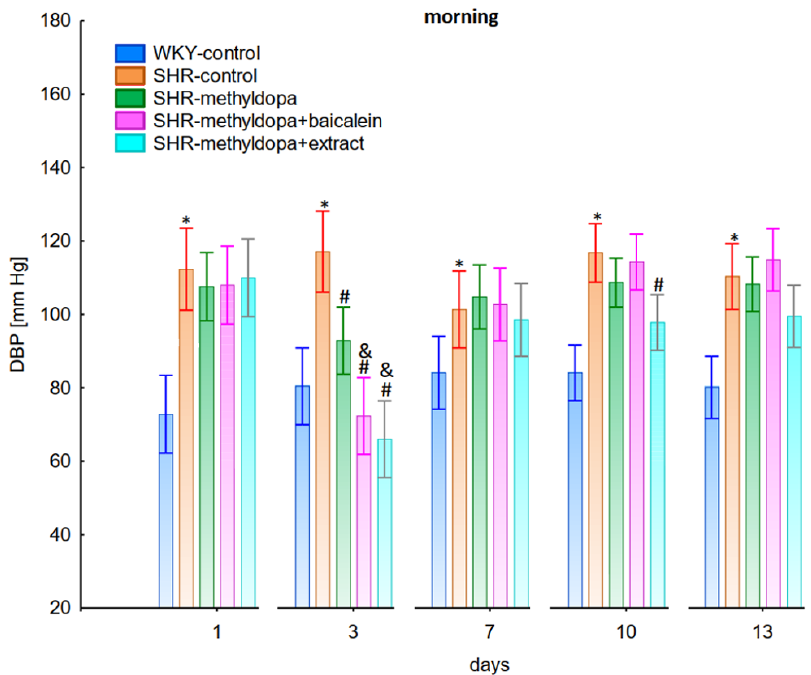
Figure 2. Influence of methyldopa and its combination with baicalein or extract from Scutellaria baicalensis roots on morning diastolic blood pressure (DBP) in SHR pregnant rats. Legend: n = 10, mean ± SEM; *—vs. WKY control, p < 0.05, #—vs. SHR control, p < 0.05; &—vs. SHR-methyldopa, p < 0.05.